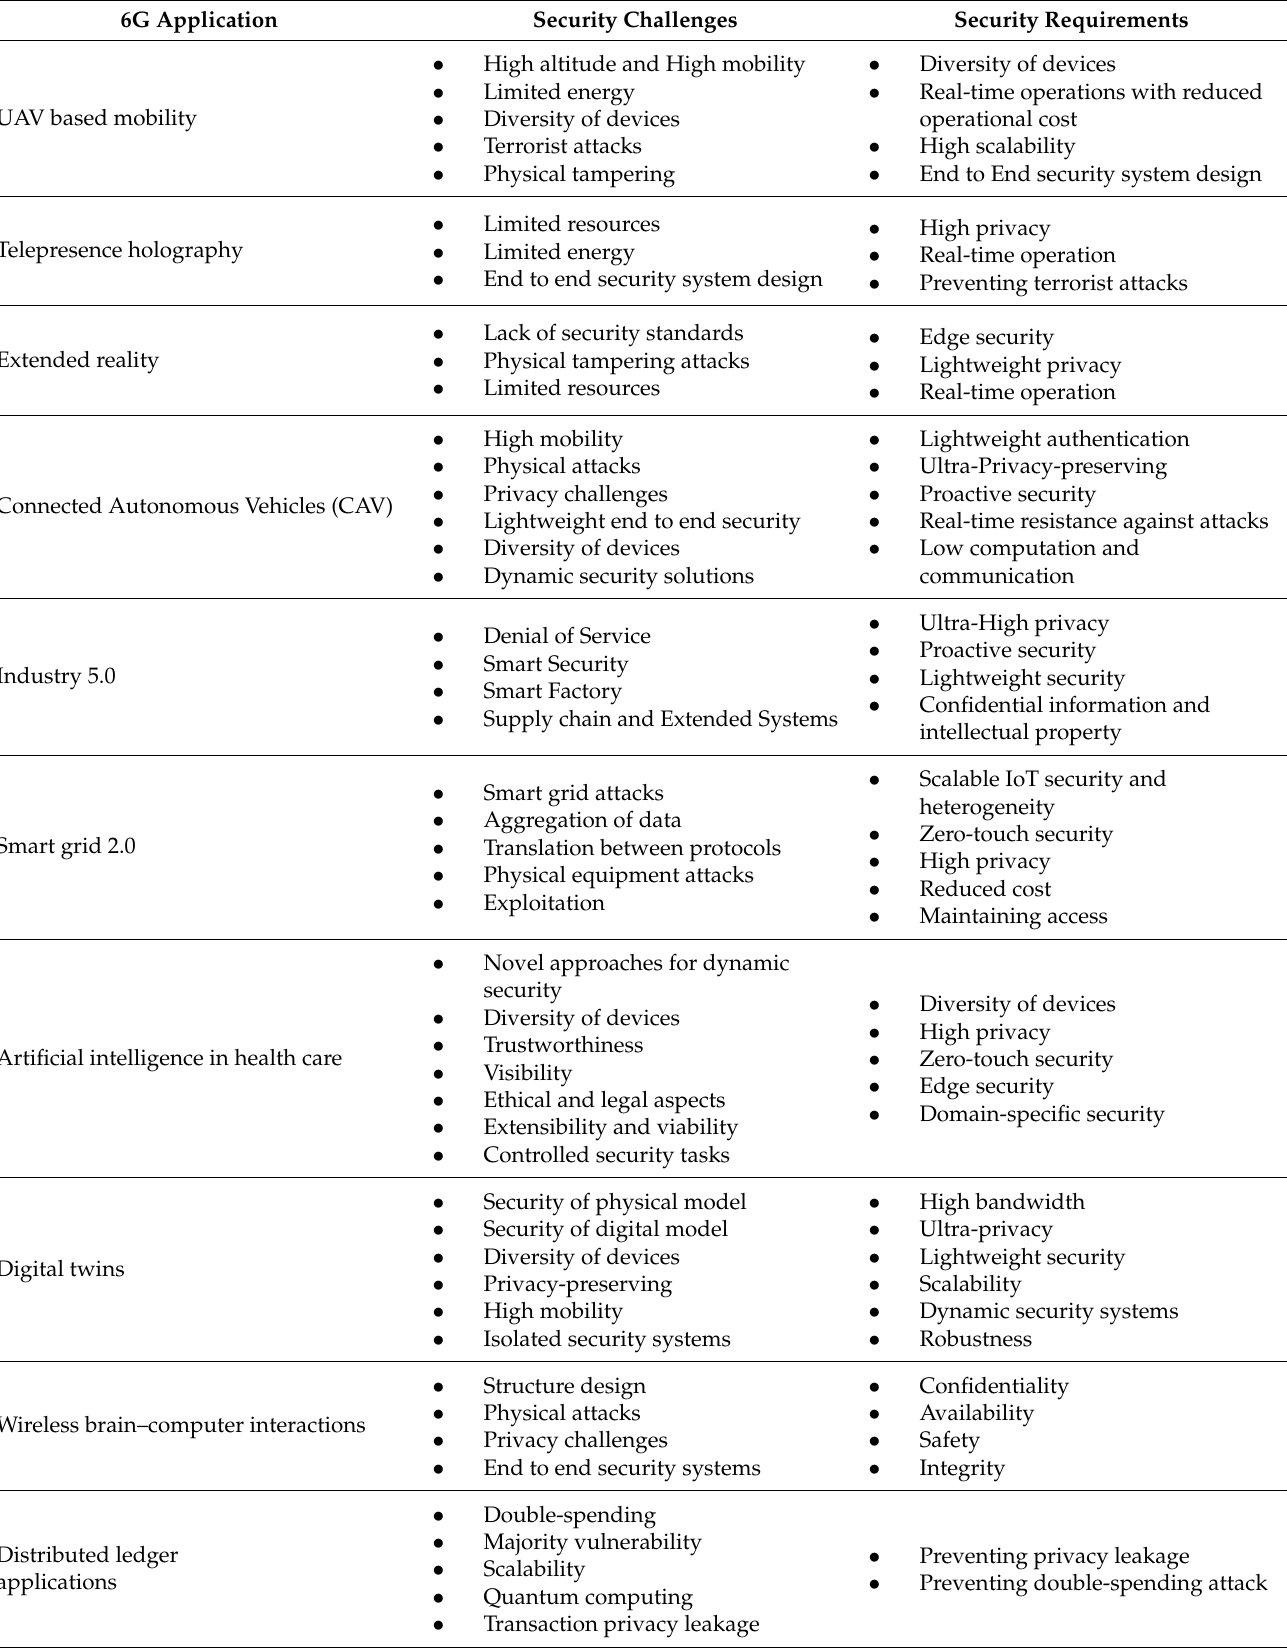
Table 4. The 6G applications security challenges and the basic security